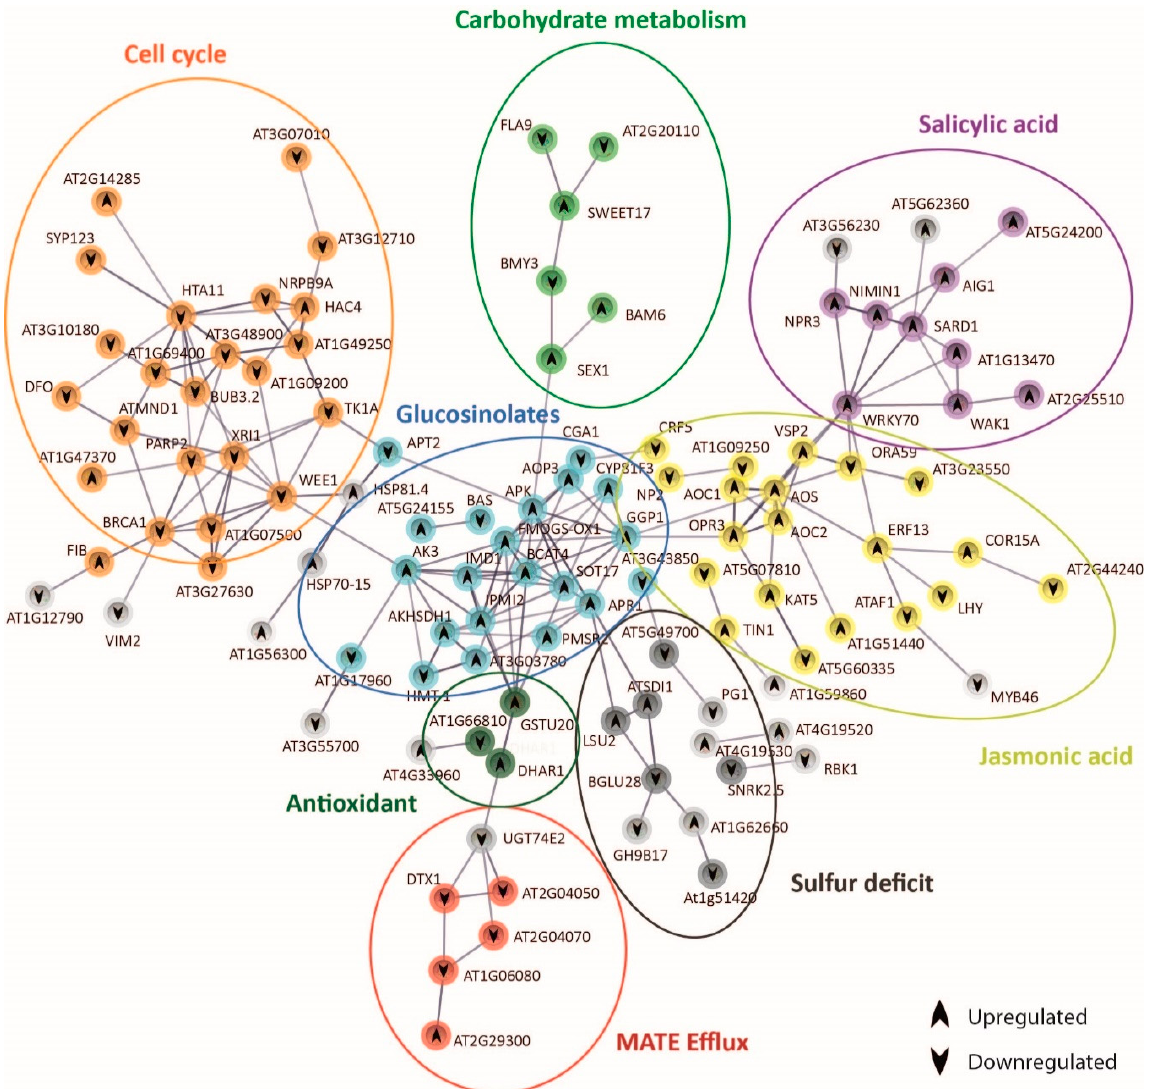
Figure 5. Protein–protein interaction network functional enrichment analysis of specific genes derived from the response to bicarbonate of A1 (c+) . Gene protein interaction network of A1 (c+) exclusive DEGs from bic vs. pH 5.9 comparison after 3 h exposure. Each sphere corresponds to one gene and nodes represent protein interactions. Gene pathways are shown in different colors. Arrows indicate up- or downregulation of the genes.